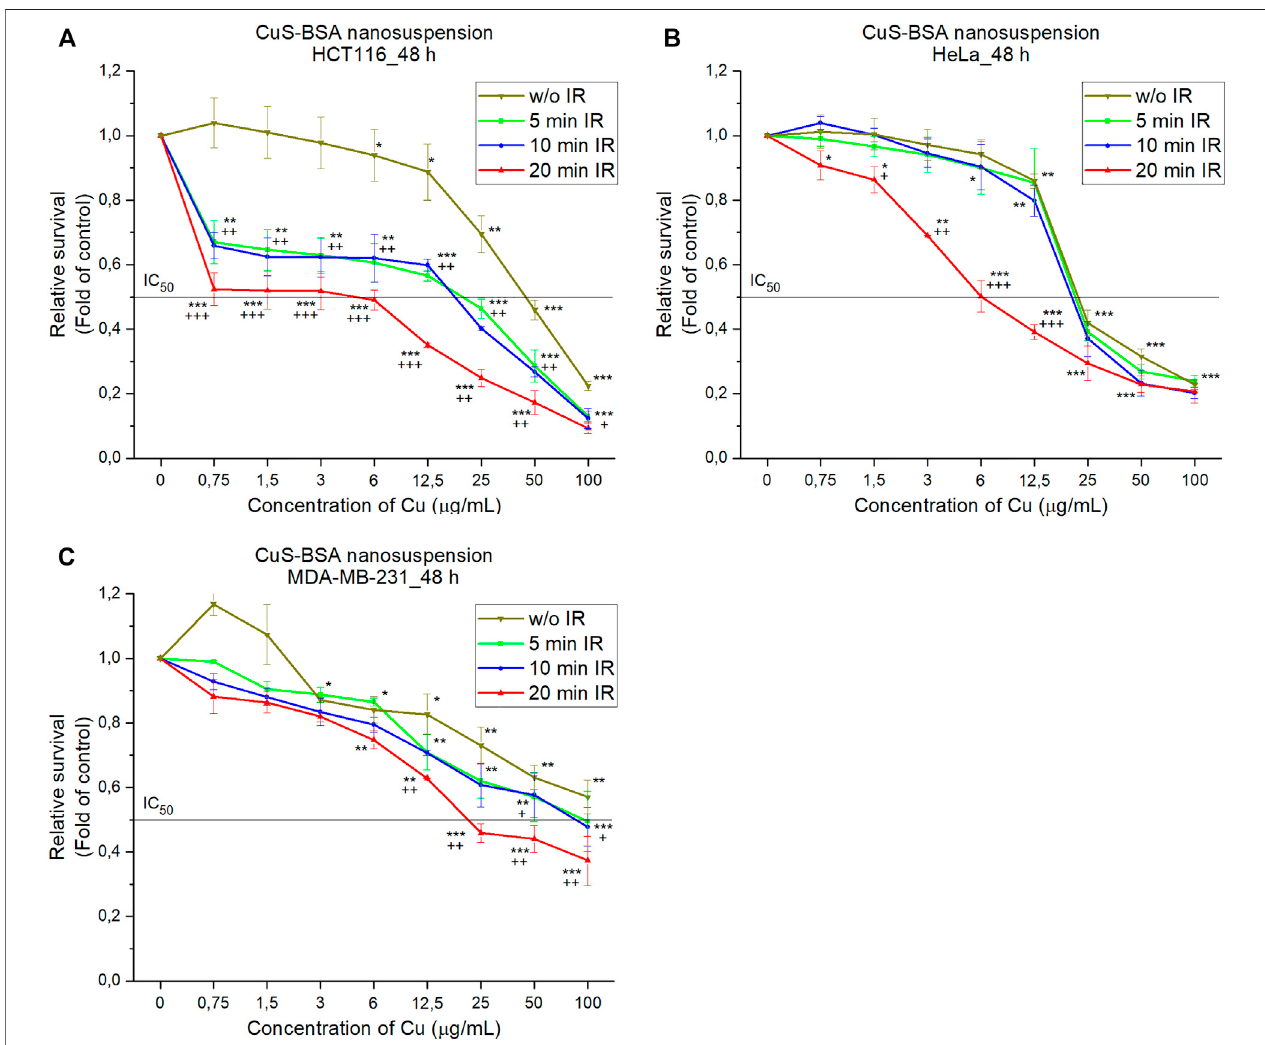
FIGURE14| Radiationtherapyof (A) HCT116, (B) HeLaand (C) MDA-MB-231cellstreatedwithCuS-BSA nanosuspensionsfor48 hfollowedbyirradiationfor5, 10and20 min.Thedataarepresentedfromthreeindependentexperiments.Signi fi cantlydifferent* p < 0.05,** p < 0.01,*** p < 0.001vsuntreatedcells(control)and+ p < 0.05, ++ p < 0.01, +++ p < 0.001 irradiated vs non-irradiated